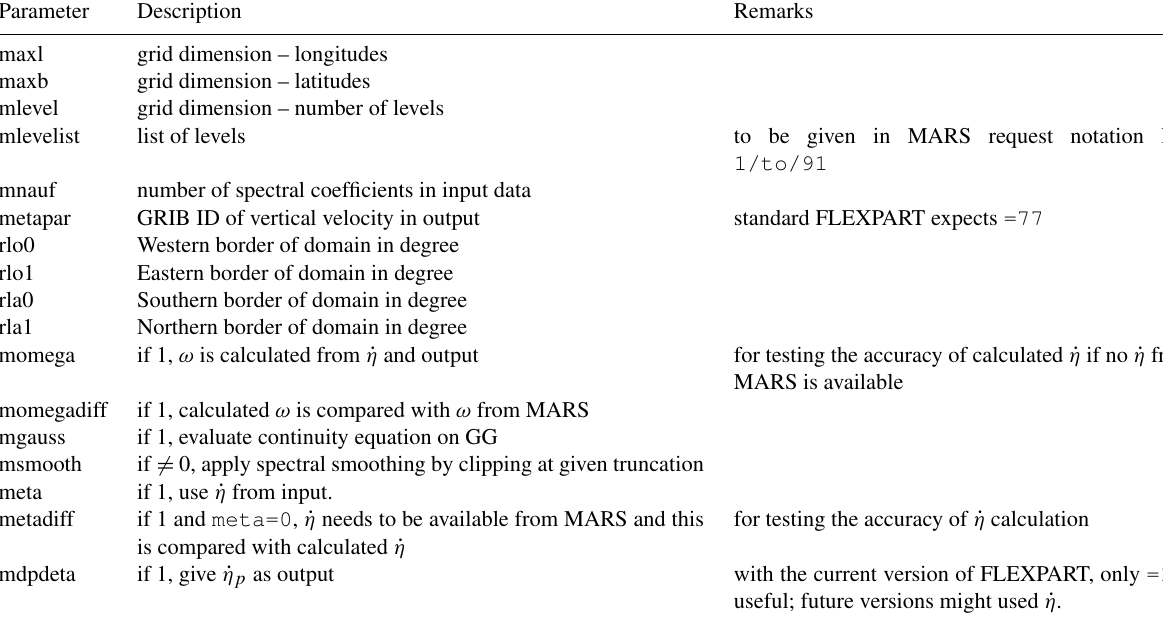
Table 14. Overview of options controlling calc_etadot . Note that the resolution of the latitude–longitude grid is given implicitly by the grid dimensions and extent.